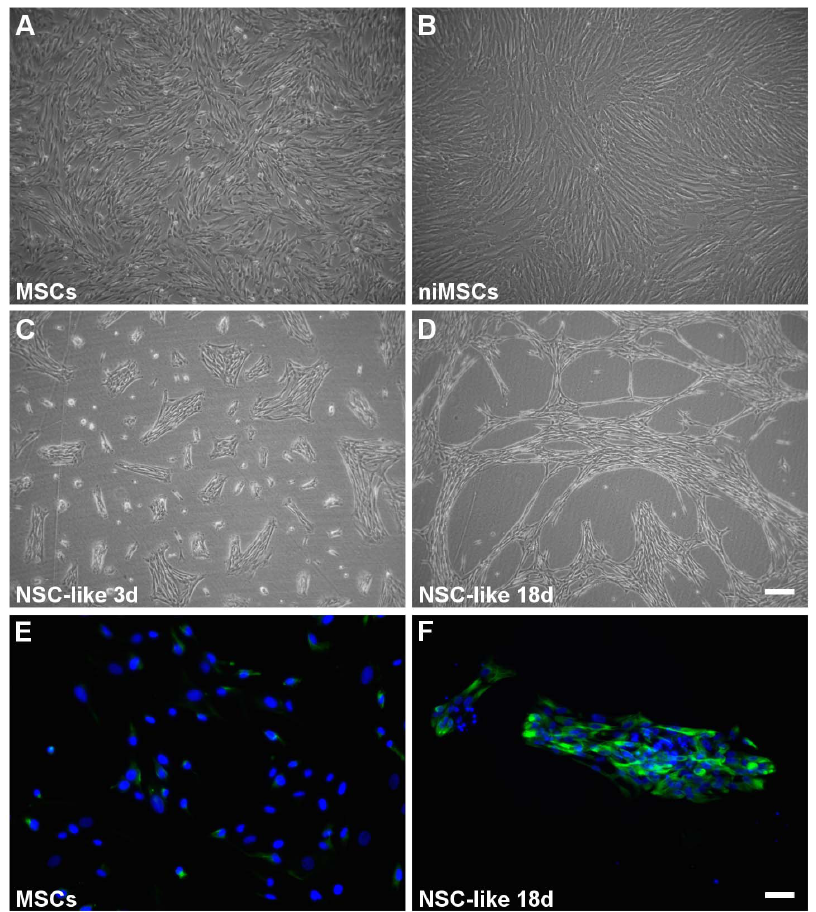
Figure 3. Cell morphology and expression of nestin in hUCM-MSC and during the first steps of differentiation. Phase contrast images of undifferentiated hUCM-MSCs ( A ), neuroectodermal-like induced MSCs – niMSCs ( B ) and NSC-like cells after 3 ( C ) and 18 days ( D ) in culture in NSC induction medium. Immunofluorescence microscopy images for the neural precursor marker nestin (in green) in undifferentiated MSCs ( E ) and NSC- like cells ( F ). Counterstaining of nuclei was performed with DAPI (in blue). In ( A-D ) the scale bar represents 200 m m and in ( E-F ) represents 50 m m. Images are representative of at least 3 independent experiments.